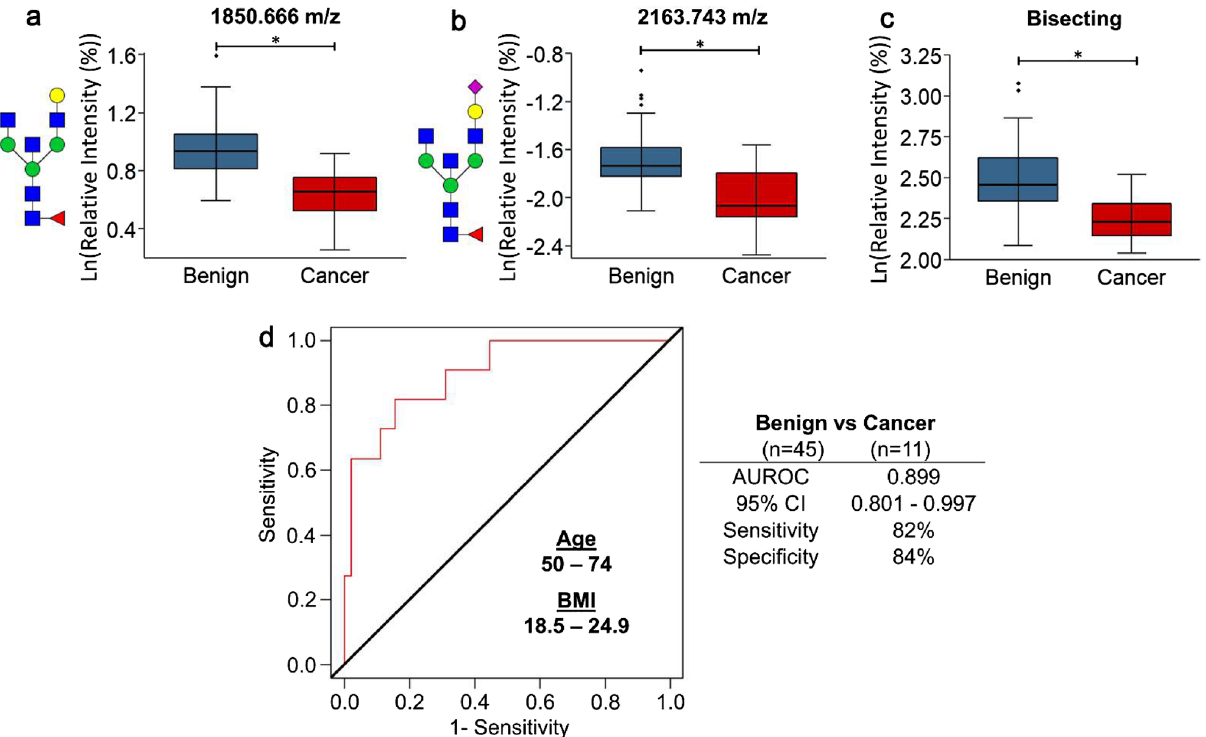
Figure 5. Serum N-glycan differences between benign (n = 45) and cancer (n = 11) samples from patients aged 50–74 and with a BMI of 18.5–24.9. Log-transformed relative intensity values of the ( a ) 1850.666 m/z (A2BG1F1) and ( b ) 2163.743 m/z (A2BG1F1S1) N-glycans and ( c ) bisecting N-glycan class had significant differences in benign and cancer samples using a 5% false discovery rate. ( d ) Using the log-transformed relative intensities of the two individual N-glycans, age, and BMI, benign and cancer samples could be distinguished with an AUROC of 0.899, sensitivity of 82%, and specificity of 84%. N-glycan compositions are represented by blue squares for N -acetylglucosamine, green circles for mannose, yellow circles for galactose, purple diamonds for sialic acid, and red triangles for